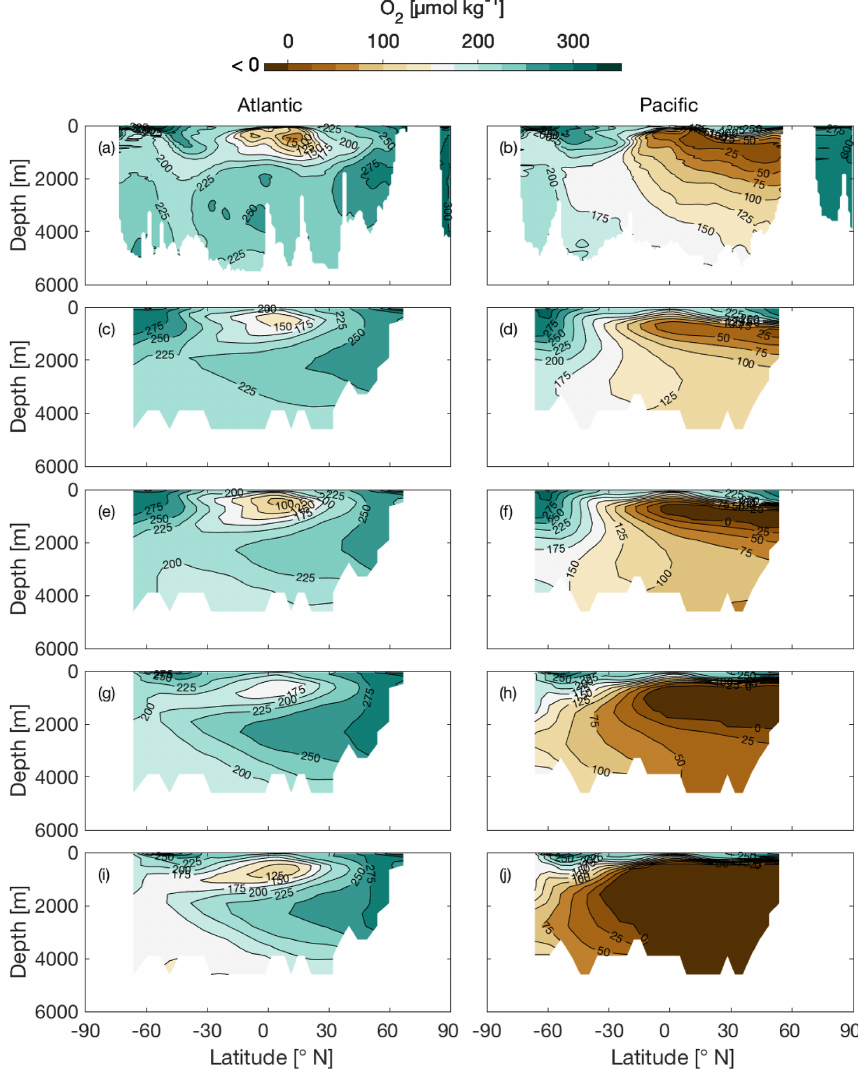
Figure 4. Sections of O 2 concentration (µmolkg − 1 ) along 25 ◦ W in the Atlantic basin (left-hand column) and along 135 ◦ W in the Pacific basin (right-hand column). Panels show climatological mean fields (World Ocean Atlas 2018, Garcia et al., 2018c) (a, b) and model states Ctrl RED (c, d) , Ctrl GAM (e, f) , GLcomb RED (g, h) , and GLcomb GAM (i, j)